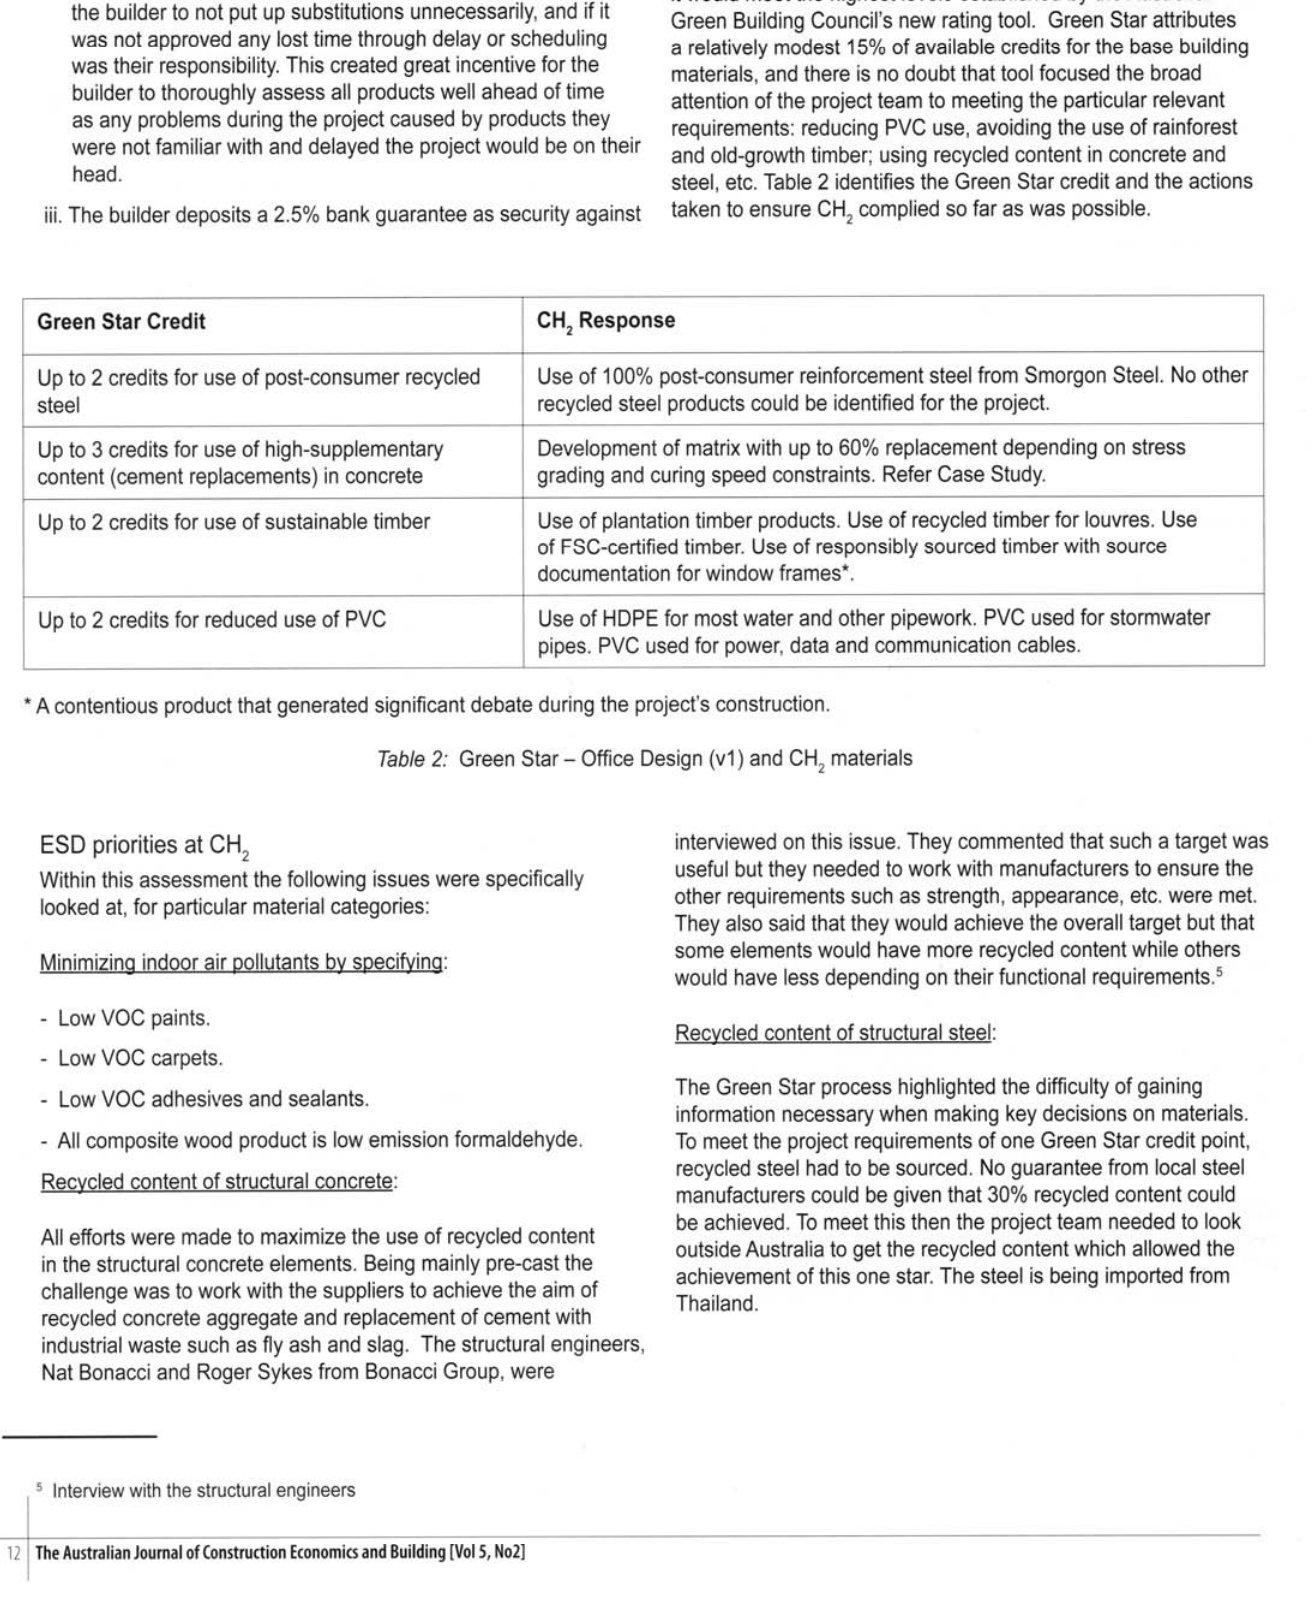
Table 2: Green Star - Office Design (v1) and CH